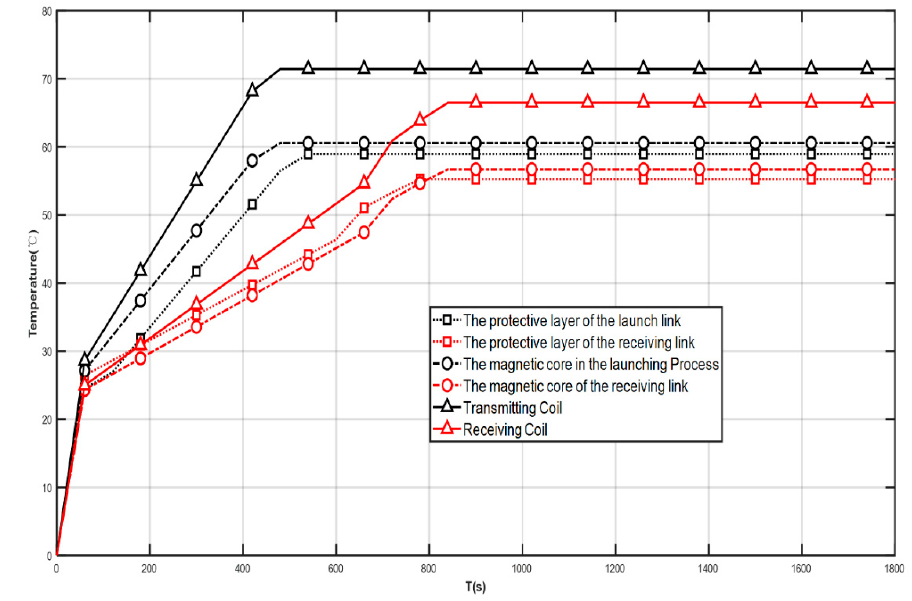
Figure 12. Plate layer temperature